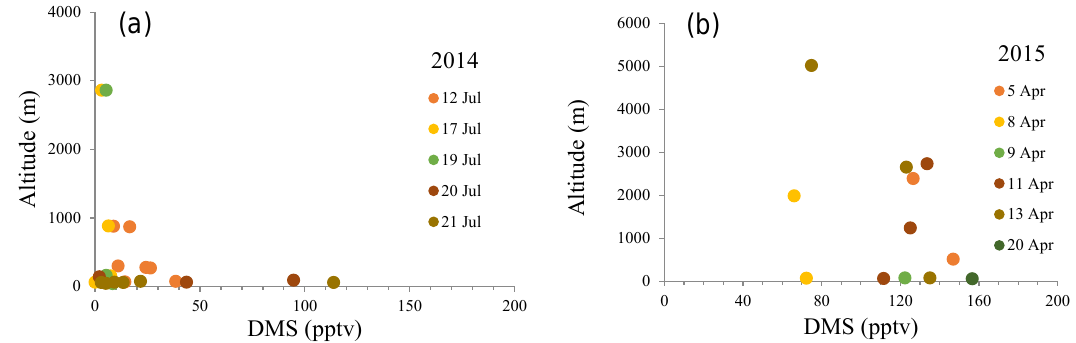
Figure 4. Sampling altitudes (m) vs. DMS mixing ratios (pptv) for July 2014 (a) and April 2015 (b)